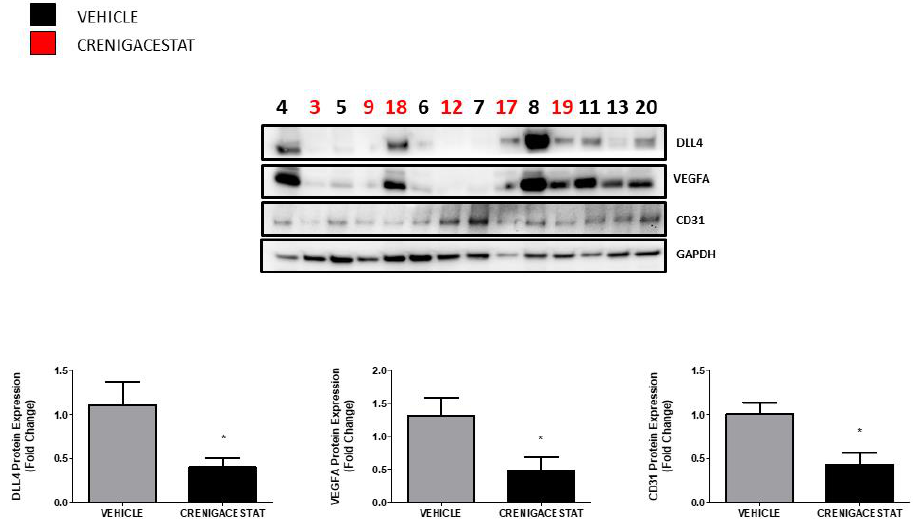
Figure 5. Crenigacestat inhibits angiogenesis in HuCCT1-xenograft model. Western blotting identi- fied a significant downregulation of CD31 (* p < 0.05), DLL4 (* p < 0.05), and VEGFA (* p < 0.05) protein expression, involved in angiogenesis, in treated HuCCT1-xenograft tissues normalized to GAPDH protein expression for each tissue. The graphs show the semi-quantitative evaluation by densitometry analysis of protein, comparing the average intensity value of the bands of CD31, DLL4, and VEGFA among all the mice treated with Crenigacestat versus vehicle. Tumor masses of HuCCT1-xenograft mice n = 8 for vehicle treatment, n = 6 for LY3039478 treatment.